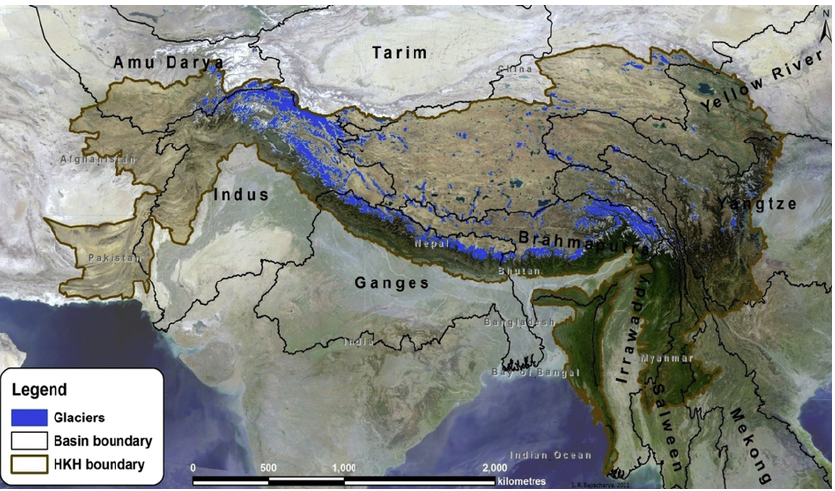
Figure A1. A geographical map of Hindu Kush Himalayas region, reprinted from